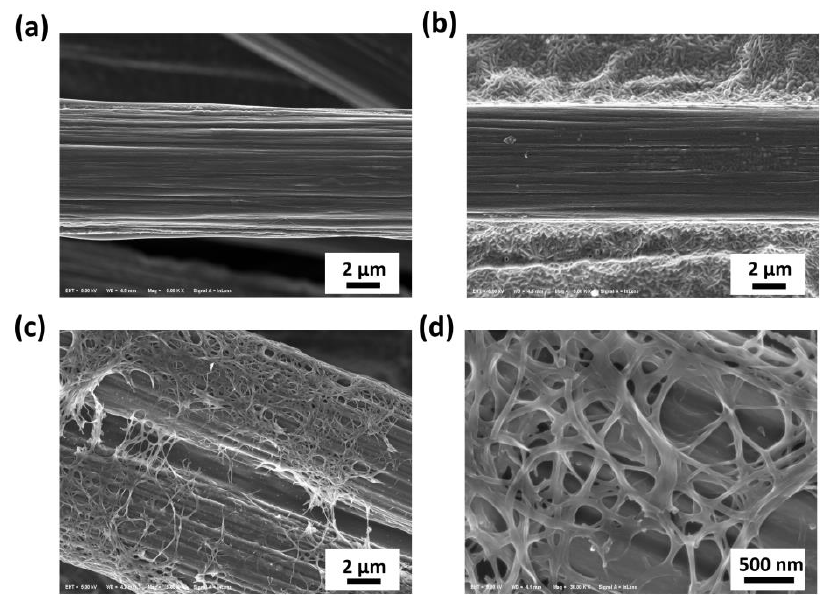
Figure 1. SEM images showing ( a ) pristine carbon paper; ( b ) hydrophobic commercial carbon paper; ( c , d ) CNF/carbon paper at 3000 × and 30,000 × magnification. Table 1. The porosity of hydrophobic commercial carbon paper and CNF/carbon paper.